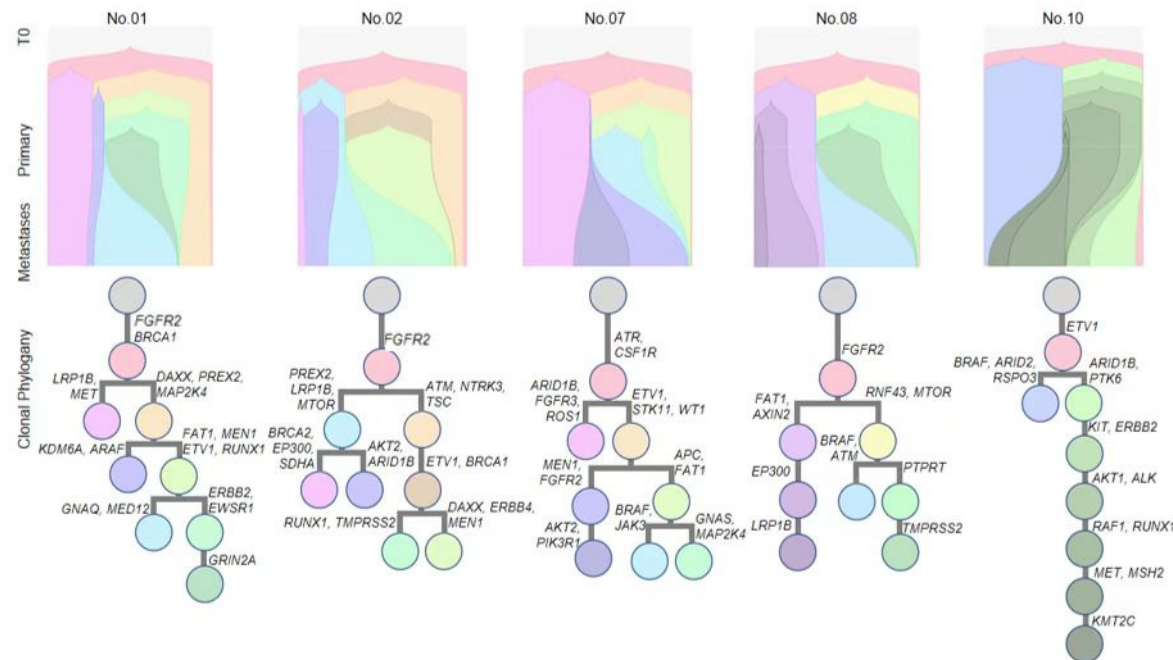
Figure 4. Clonal evolutionary structures inferred from the subclonal structure of 5 characteristic cases. We reconstructed the clonal evolutionary history and metastatic routes for other patients. Pyclone was adopted to calculate the cancer cell fractions (CCFs) of each mutation, which were then grouped into mutation clusters.